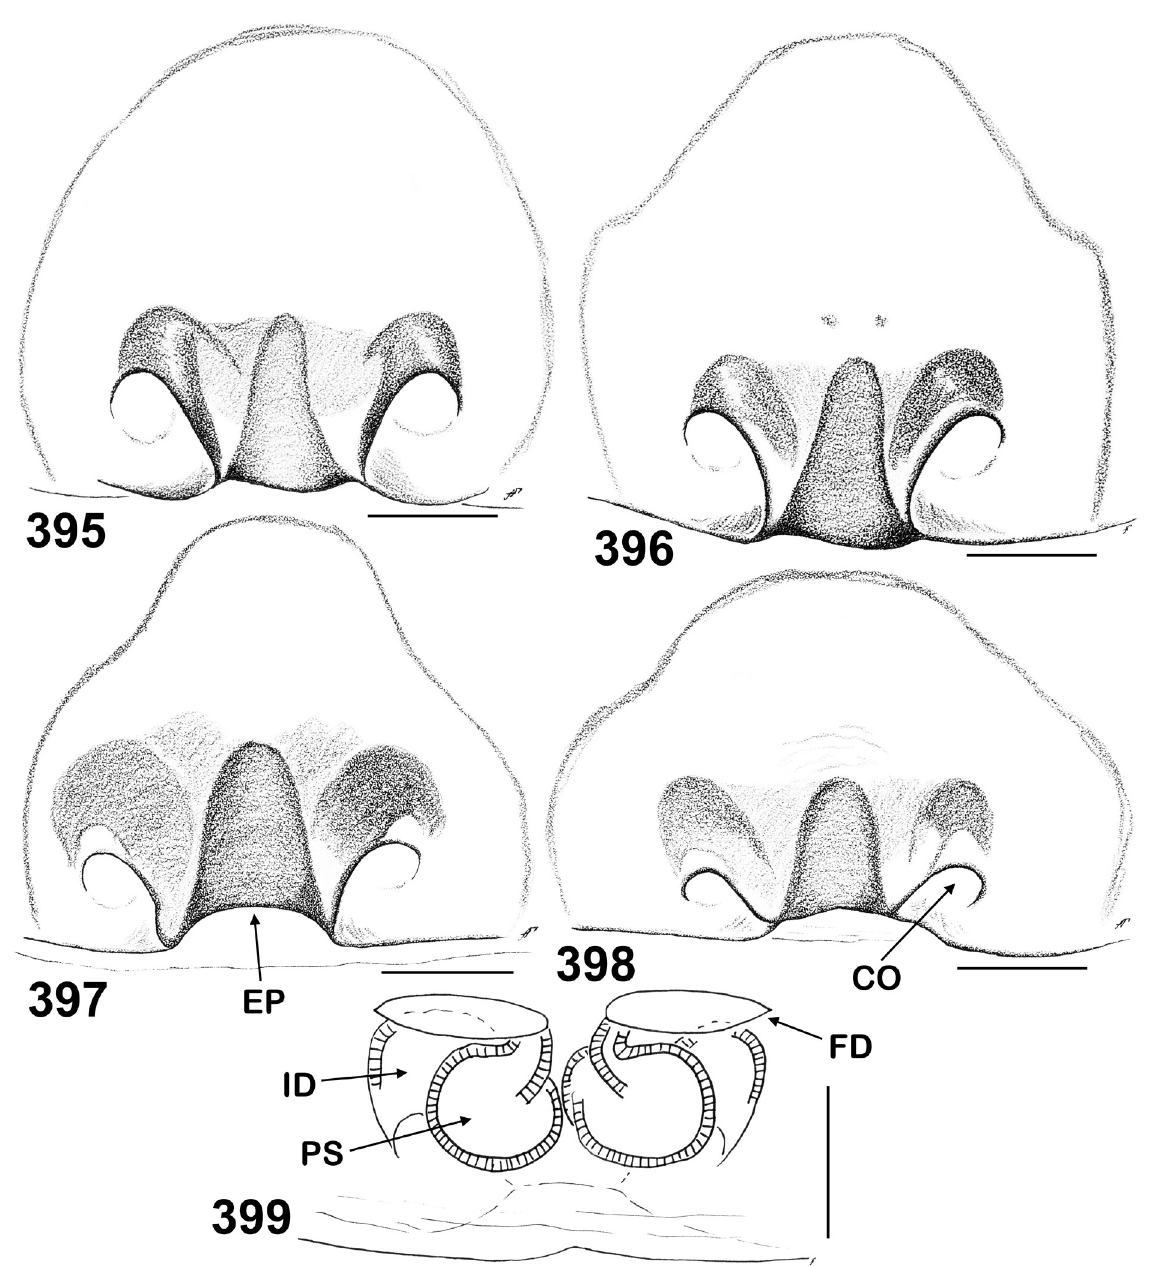
Figs 395–399. Stenaelurillus nigricaudus Simon, 1886. 395–398 . Epigyne, ventral view. 399 . Spermathecae, dorsal view. Specimens: 395–396, 399 from Senegal (Richard Toll); 397–398 from Burkina Faso. Abbreviations: see Material and methods. Scale bars: 1